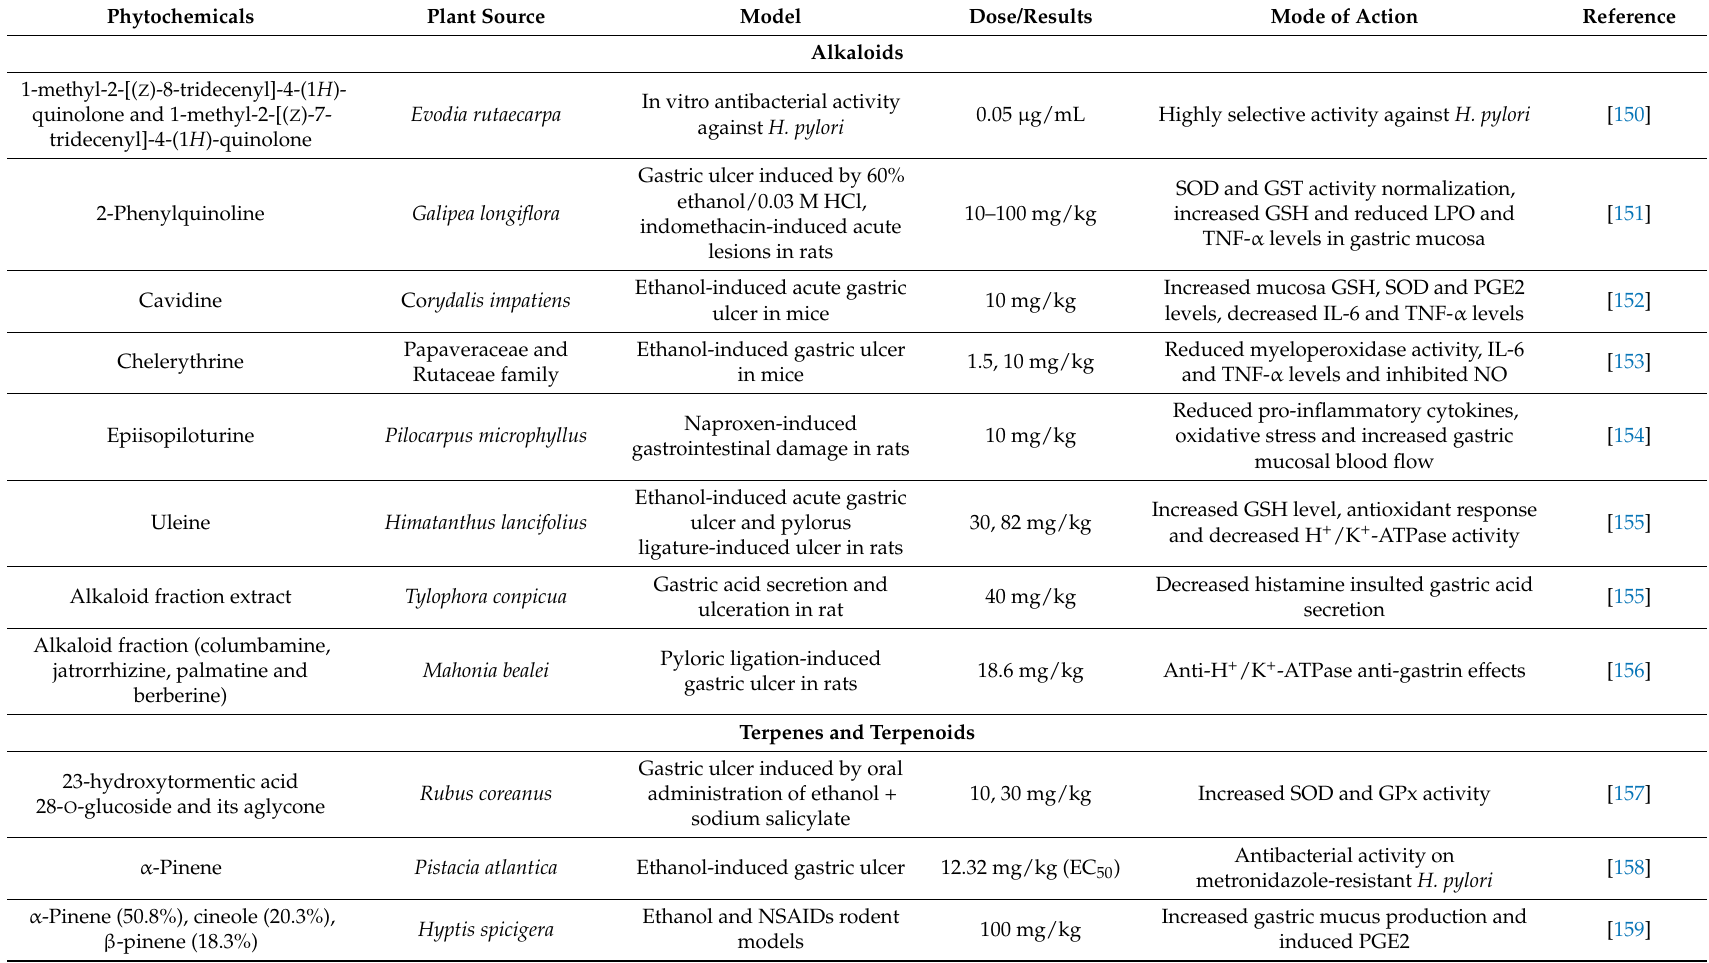
Table 3. Antiulcer activity of